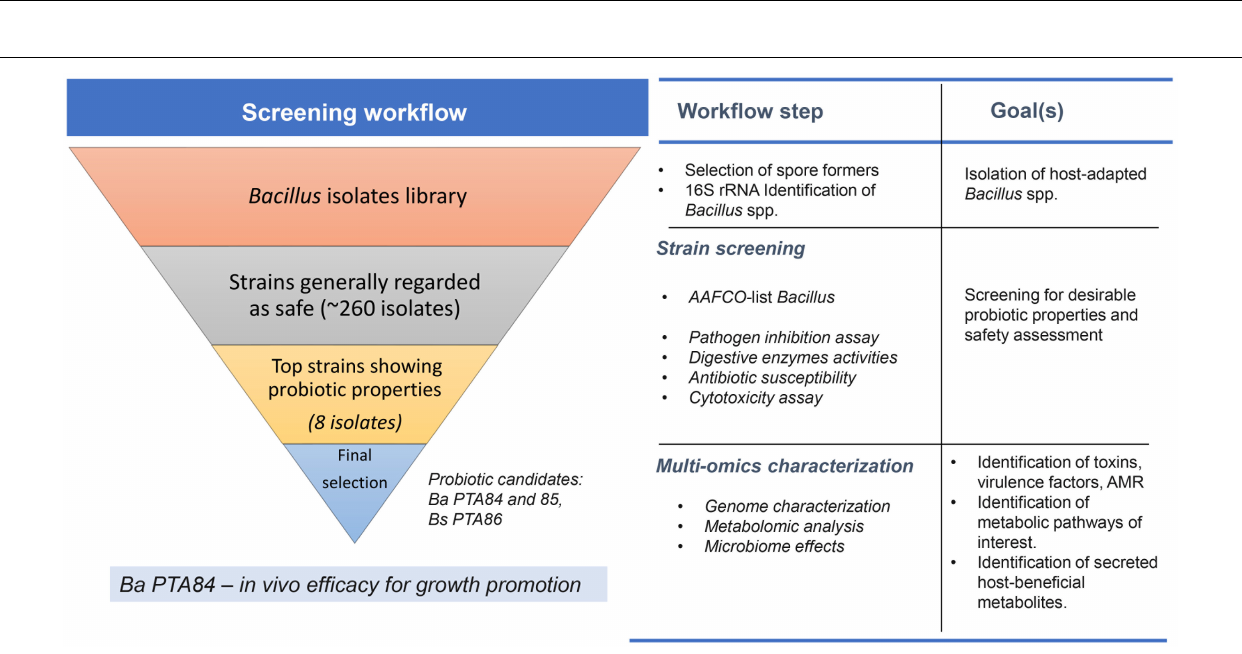
Frontiers in Microbiology |